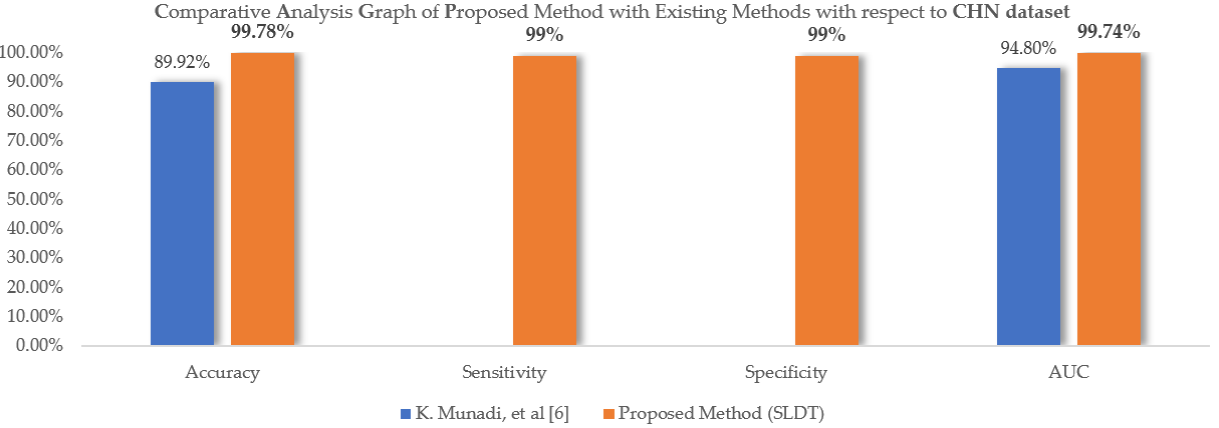
Figure 7. Comparative analysis graph of the proposed method with the existing method with respect to the CHN dataset.